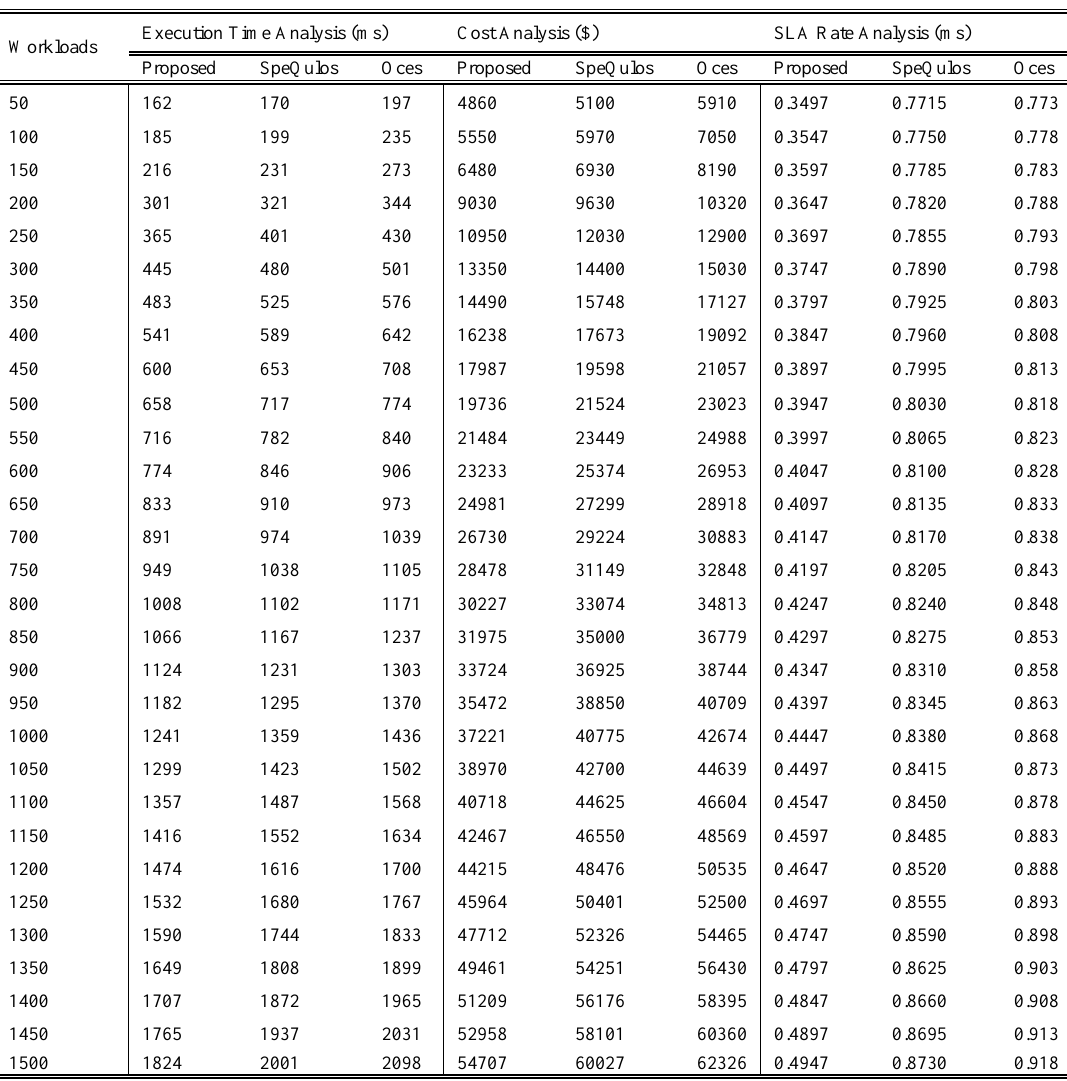
Table 2. SLA, Cost and Execution time analysis of proposed